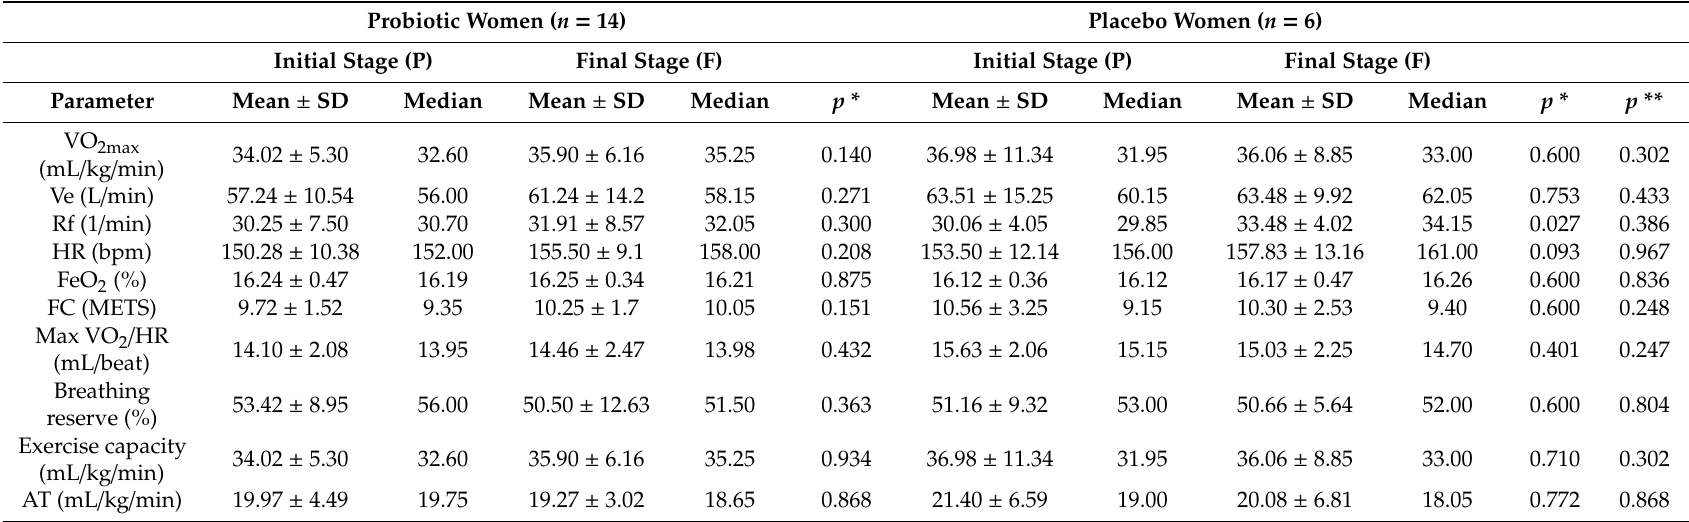
Table 3. Analysis of selected parameters of cardiorespiratory fitness of women from the probiotic and placebo groups at the initial and final stages of intervention. Probiotic Women ( n = 14) Placebo Women ( n =